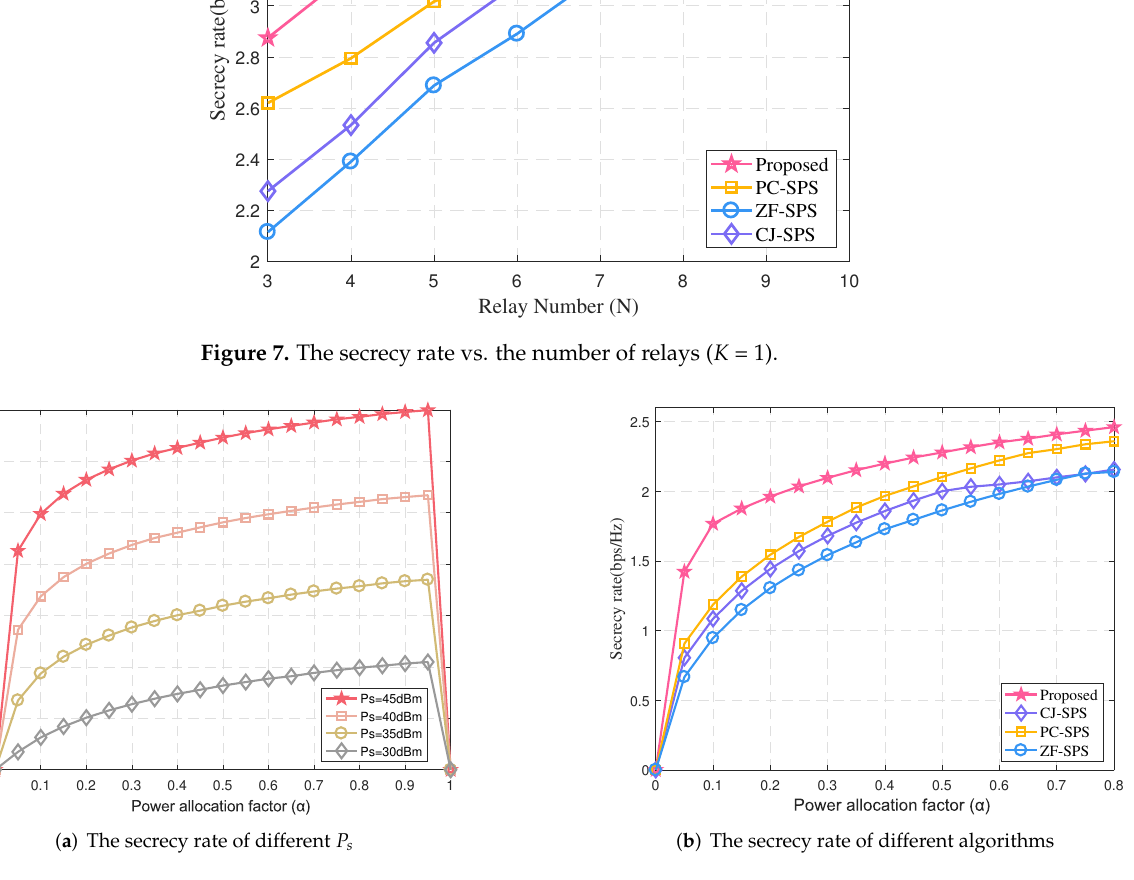
Figure 8. The secrecy rate vs. α ( N = 10, K =